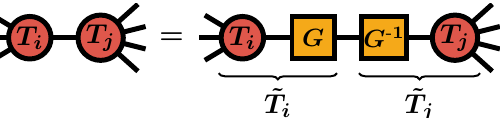
Figure 2: Gauge degree of freedom in tensor networks. At each link, one can insert an identity (cid:49) = G · G − 1 without changing the physical state | ψ 〉 . By absorbing G into one tensor and G − 1 into the other, we obtain a different representation of the same state | ψ 〉